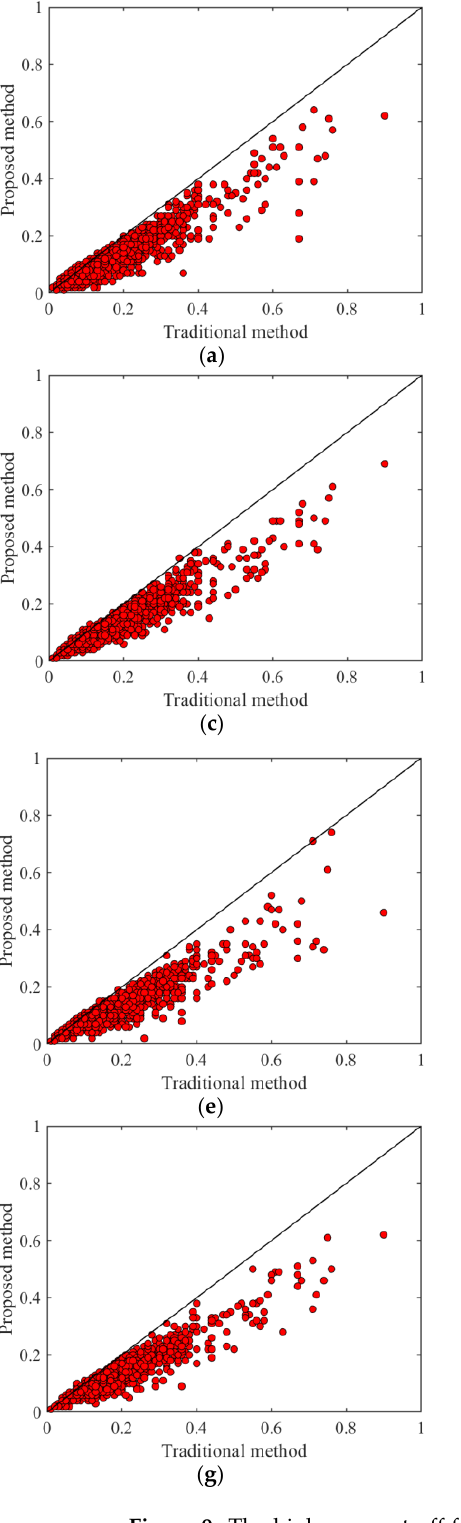
Figure 9. The high-pass cut-off frequency obtained by training the model of all layers (unit: Hz). ( a , c , e , g ) are the results of VGG19, ResNet50, InceptionV3, and InceptionResNetV2 when probabilities are not considered, respectively; ( b , d , f , h ) are the results of VGG19, ResNet50, InceptionV3, and InceptionResNetV2, respectively, when considering the probability.